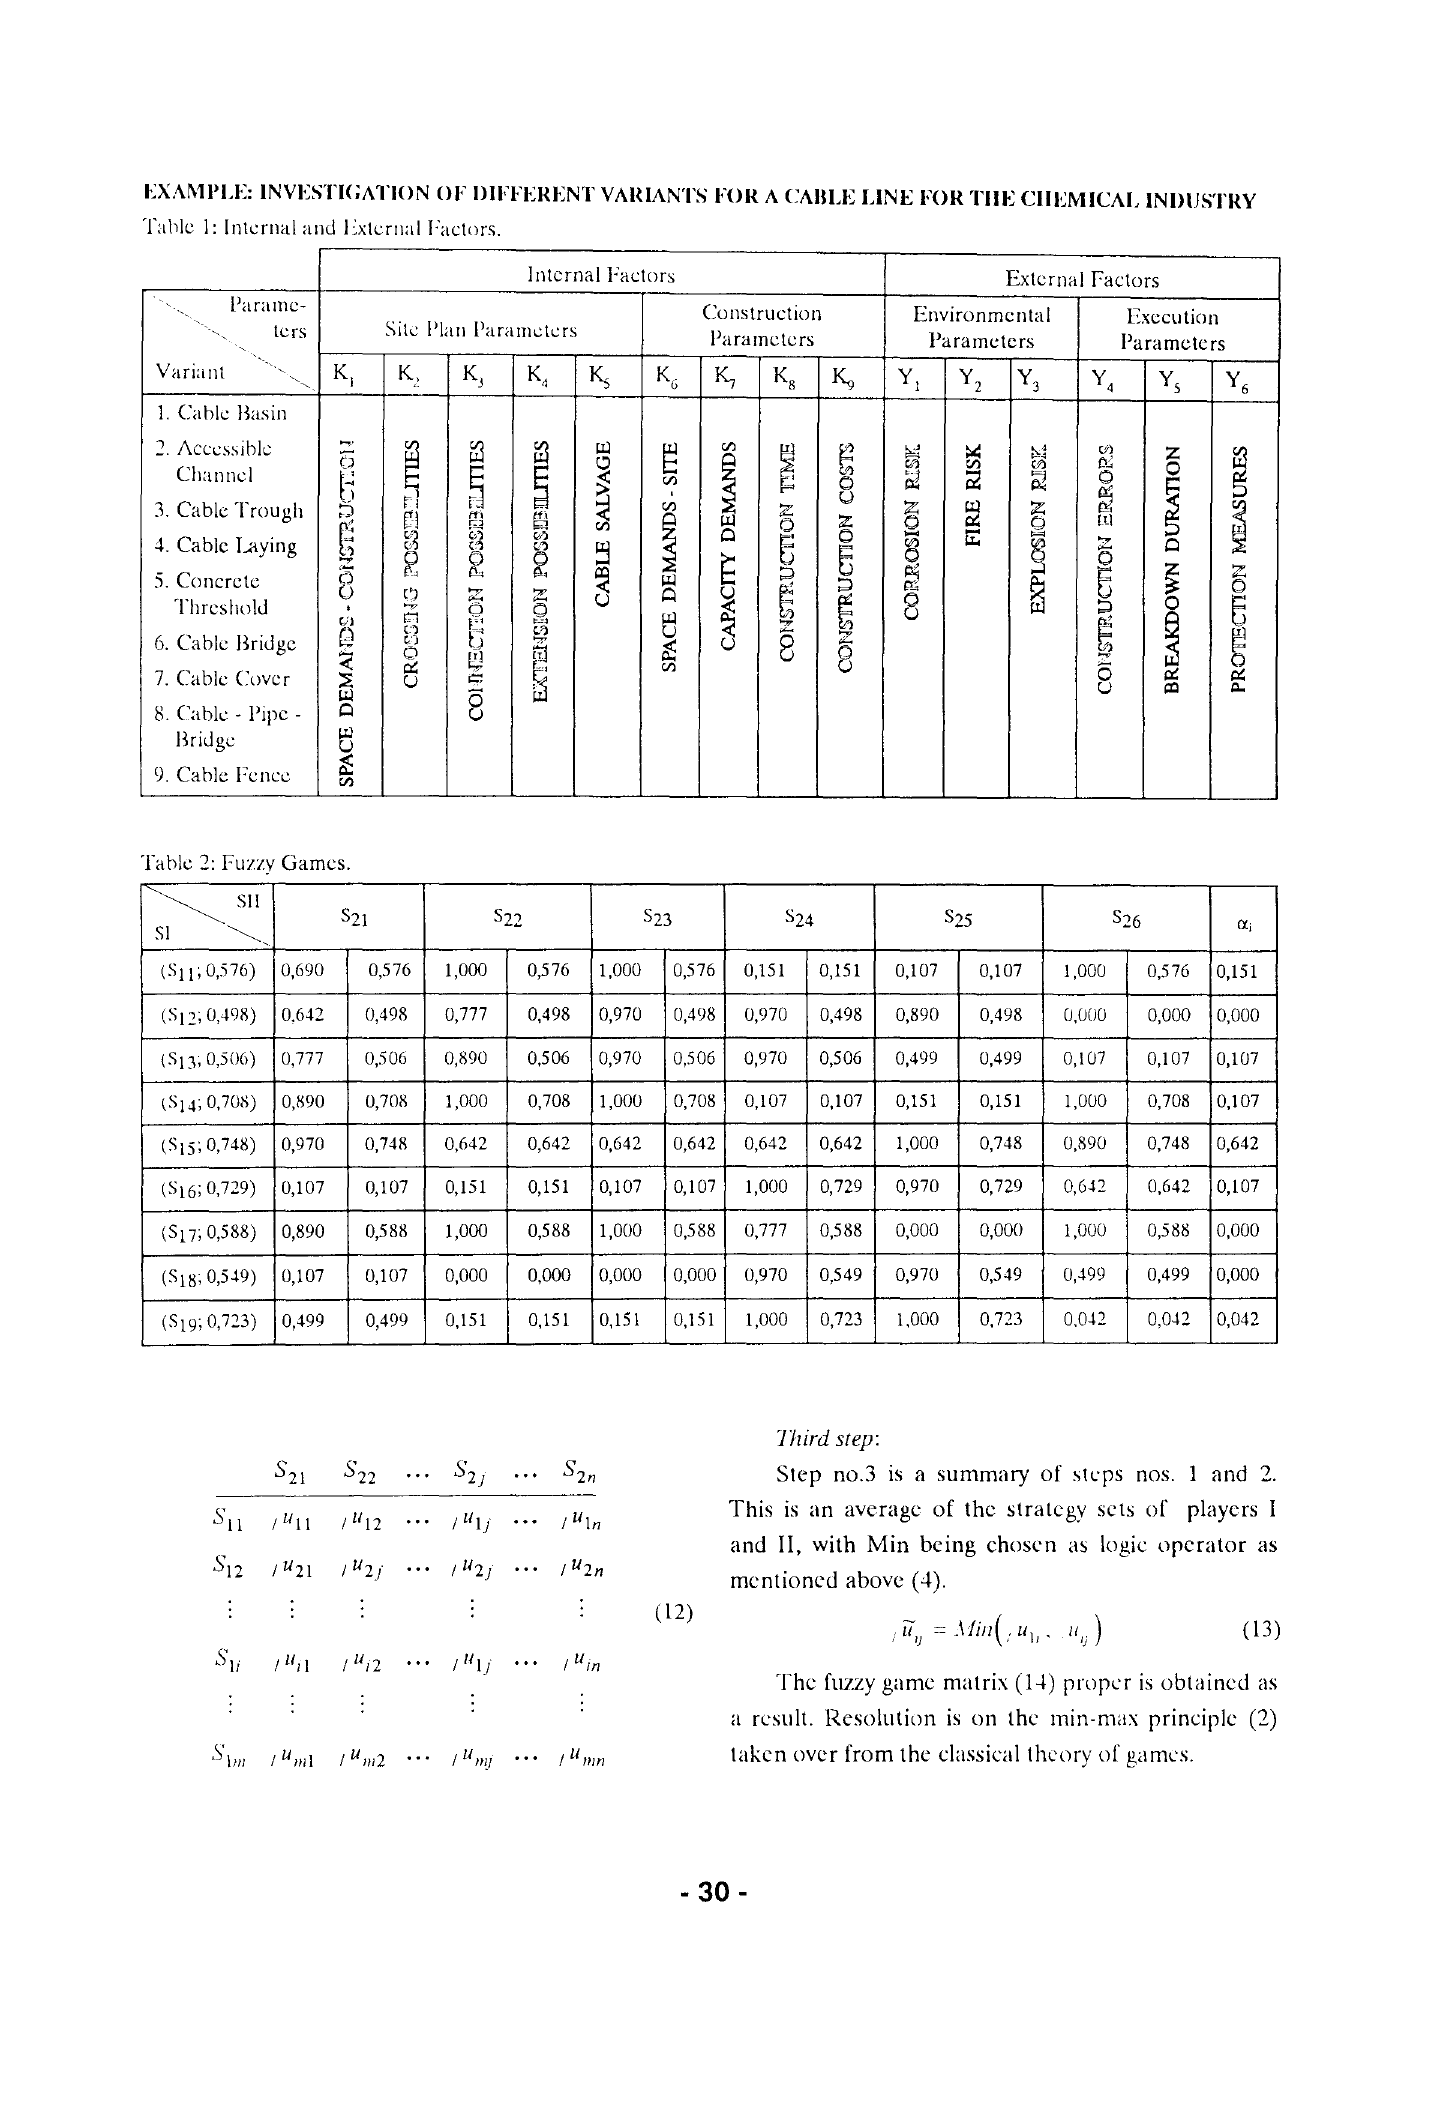
Internal Factors External factors Construction Environmental Execution Sit..: Plan l'aramcll:rs .